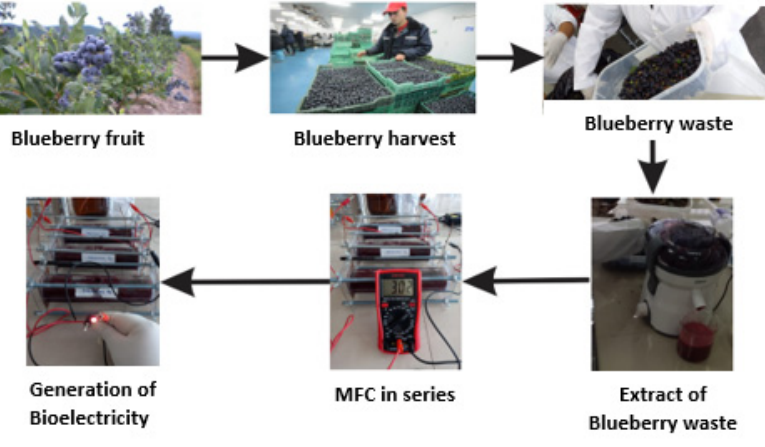
Figure 6. Scheme of Bioelectricity Production by using Microbial Fuel Cells.